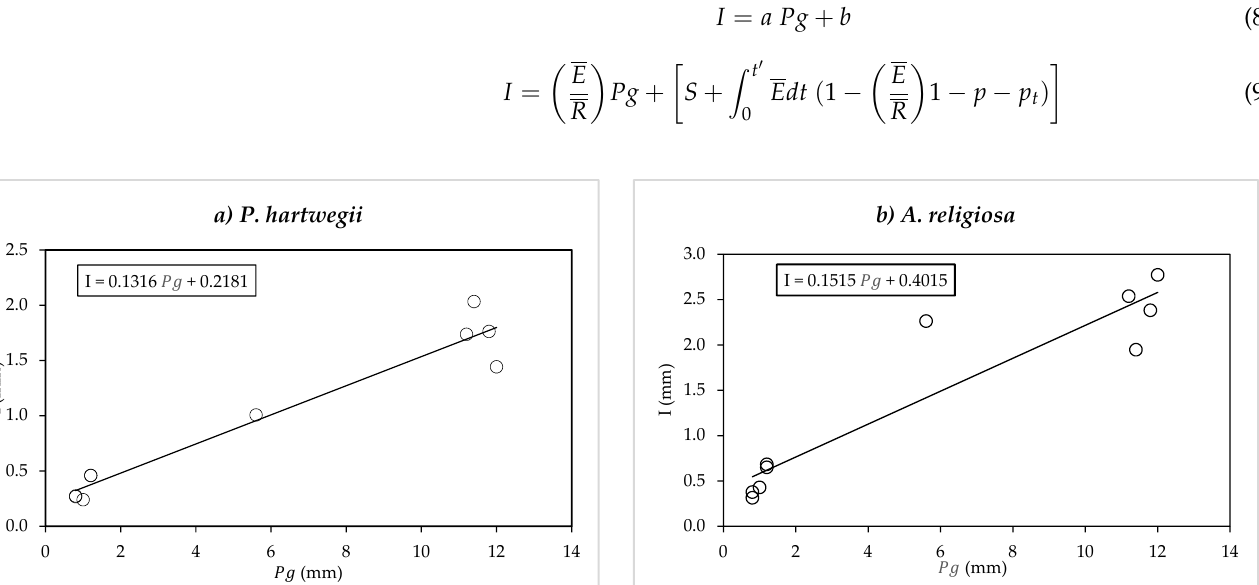
Figure 2. Relationship between the incident precipitation and rainfall interception of the events that met the canopy saturation condition, proposed by Gash, for ( a ) P. hartwegii and ( b ) A. religiosa.